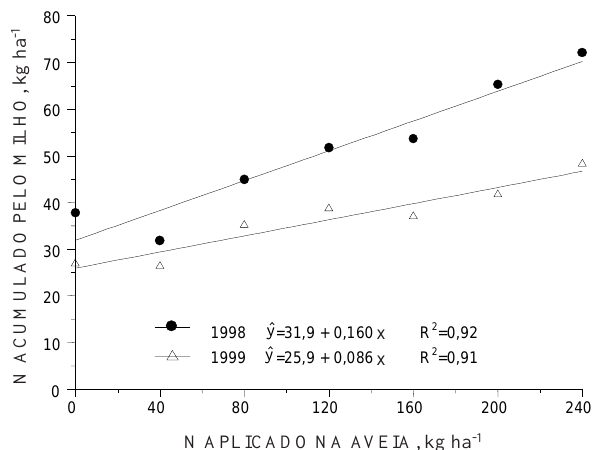
Figura 5. Relação entre o N aplicado na cultura da aveia preta e o N acumulado pela parte aérea do milho, avaliada no pendoamento, nos anos de 1998 e